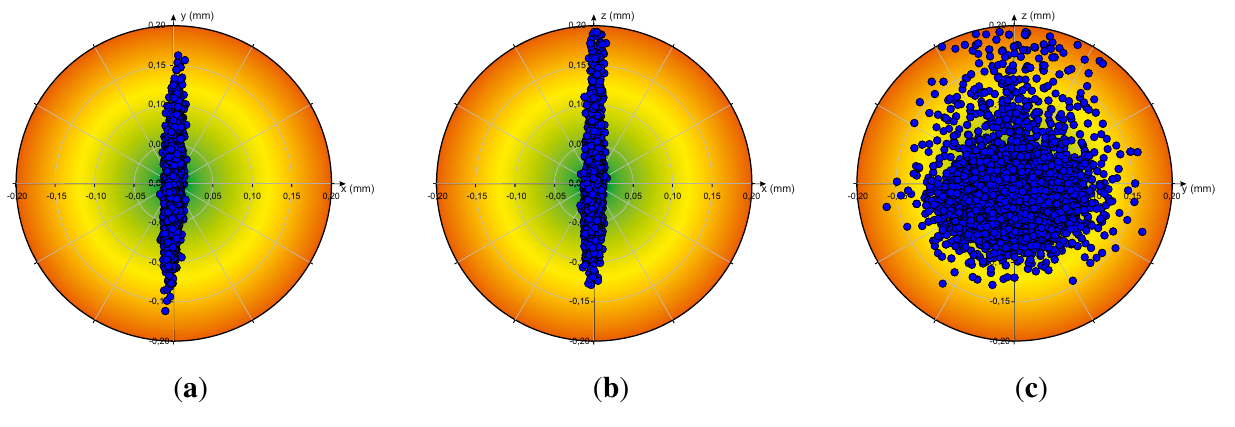
Figure 4. Analysis of the Accuracy and the Repeatability: Deviation between a desired 3D Position and the Measured Positions for a Static Position. ( a ) xy-Variation; ( b ) xz-Variation; ( c ) yz-Variation.